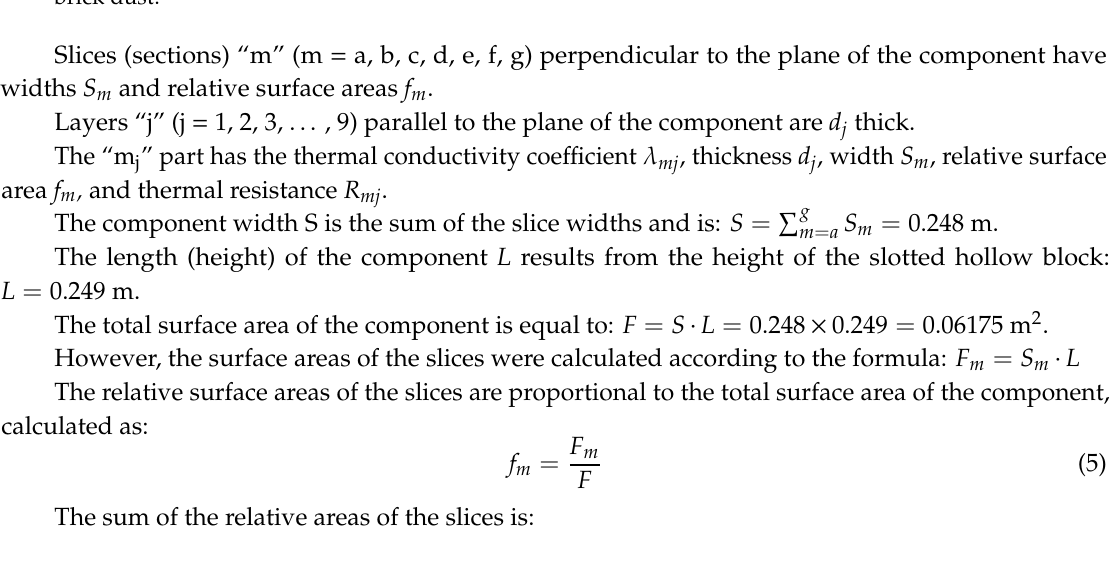
Figure 4. Layout diagram of the ceramic component layer filled with phase change material and brick dust.